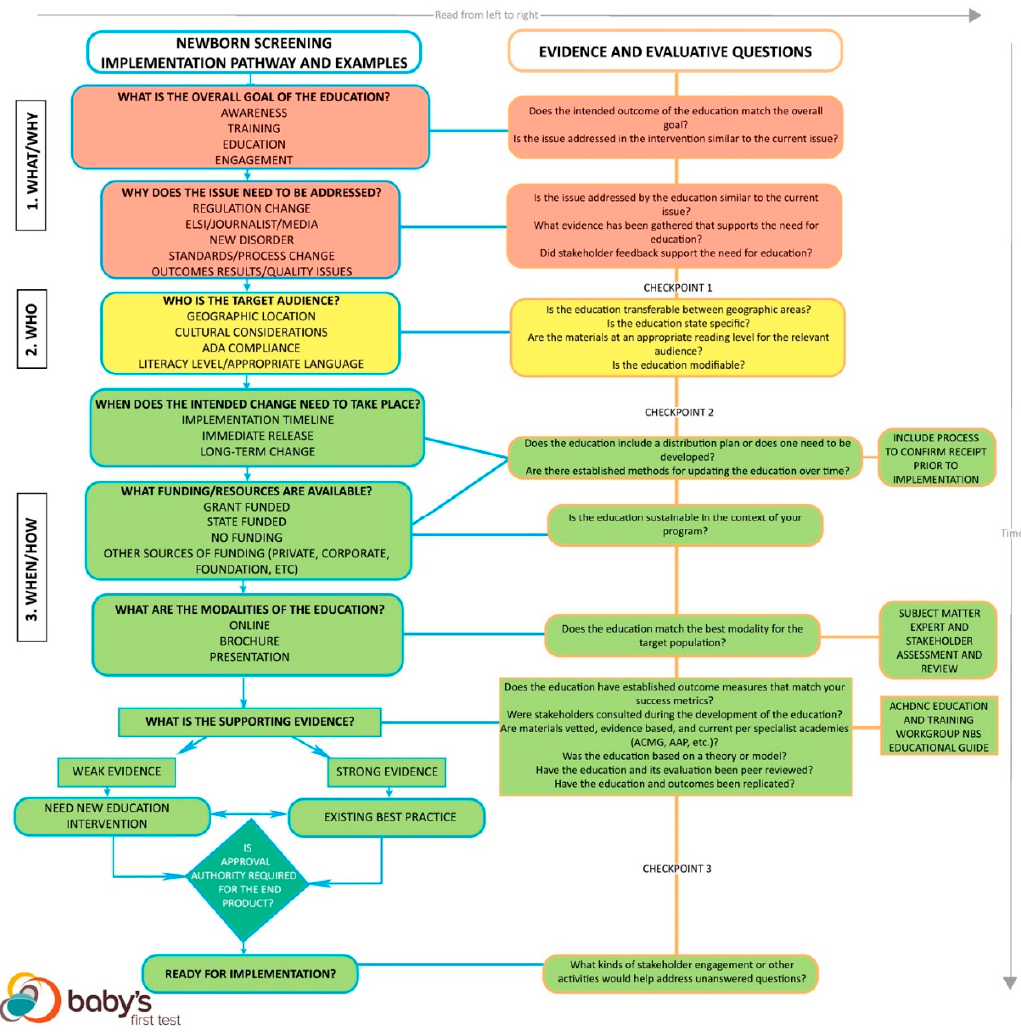
Figure 2. NBS Education Best Practices Flowchart. This figure shows the framework flowchart of the NBS Education Best Practices Framework. This flowchart takes the user through steps two and three of applying the framework. The flowchart highlights evaluative and implementation considerations.